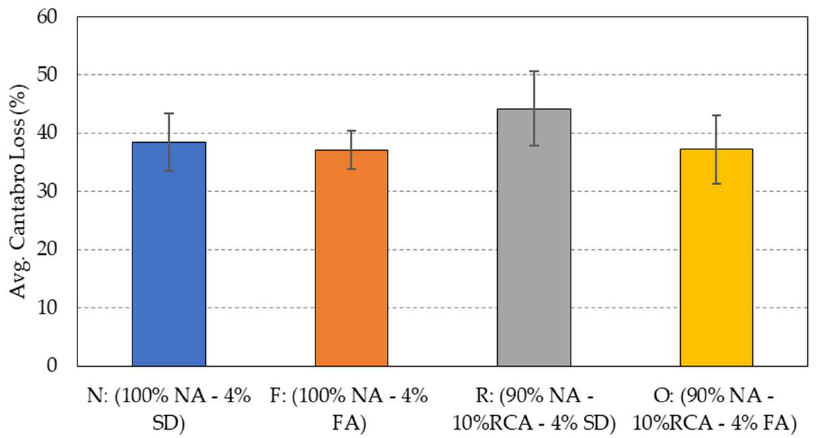
Figure 10. Average Cantabro loss of the four porous asphalt mixtures at 25